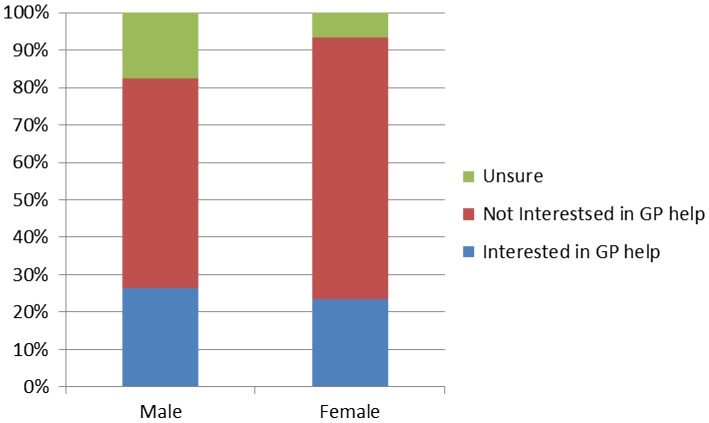
Percentage of patients who were interested in GP helps in physical activity divided by gender.